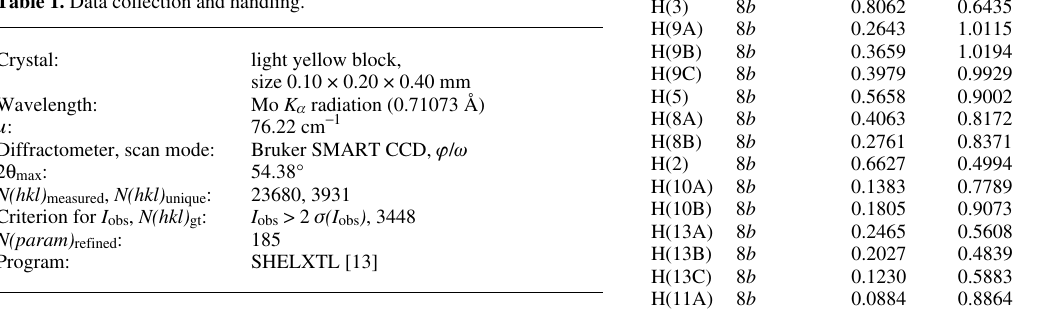
Table 1. Data collection and